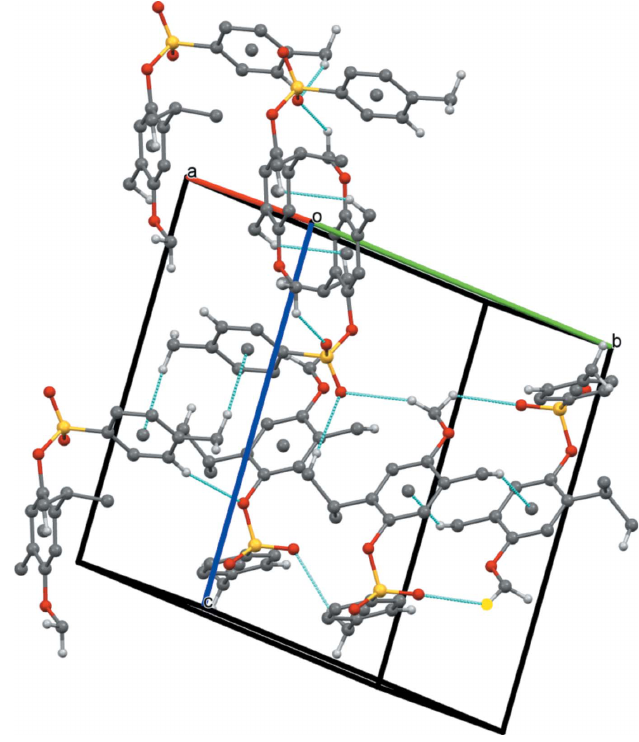
Figure 2 Partial packing view showing the C—H (cid:2)(cid:2)(cid:2) O and C—H (cid:2)(cid:2)(cid:2) (cid:2) interactions (dotted lines). Only H atoms involved in hydrogen bonding are shown.